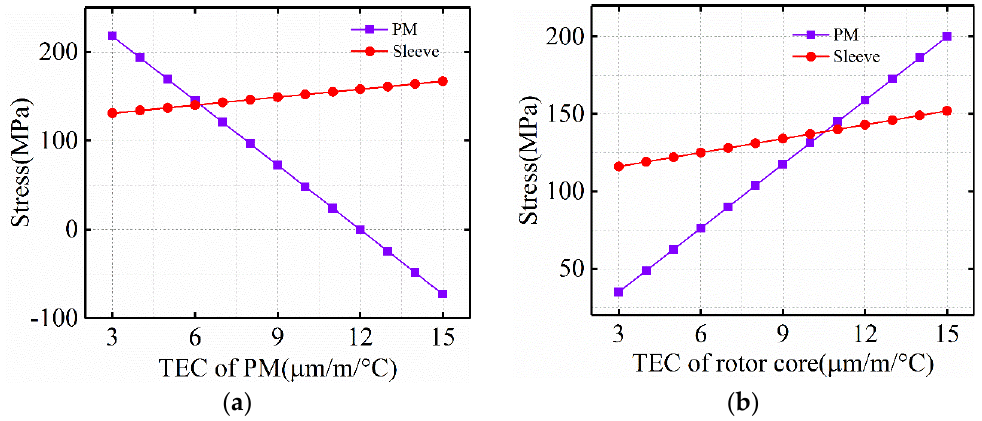
Figure 18. Influence of TEC on sleeve stress. ( a ) TEC of PM; ( b ) TEC of rotor core.